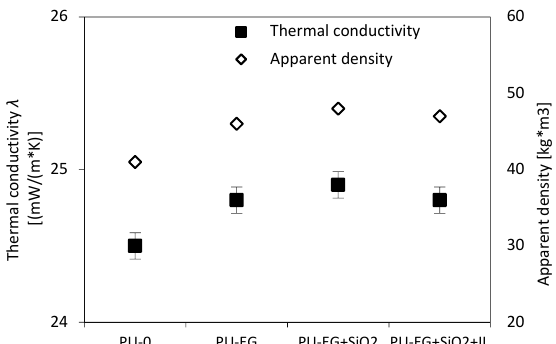
Figure 4. Dependence of the thermal conductivity coefficient at 20 °C on the apparent density of PU foams.